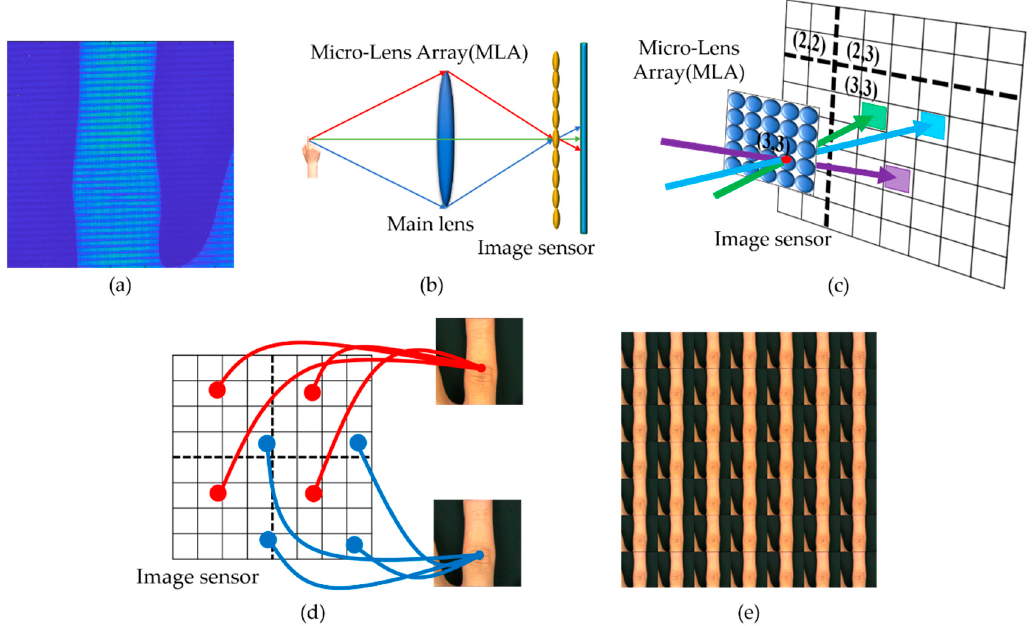
Figure 6. The overall process for obtaining multiple sub-aperture images from a Lytro camera: ( a ) is the original raw lenslet image; ( b ) shows micro-lens array structures; ( c ) simple process of recording light in each direction on an image sensor through micro-lens array; ( d ) represents pixel reordering process to generate a single view image from the image sensor; ( e ) is the obtained sub-aperture images.